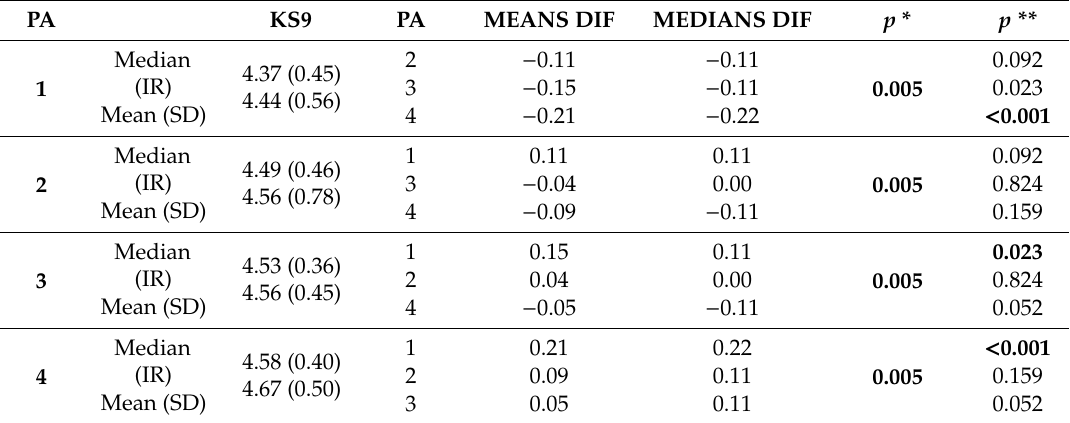
Table 2. Comparison of HRQoL, calculated by KS9, according to PA.